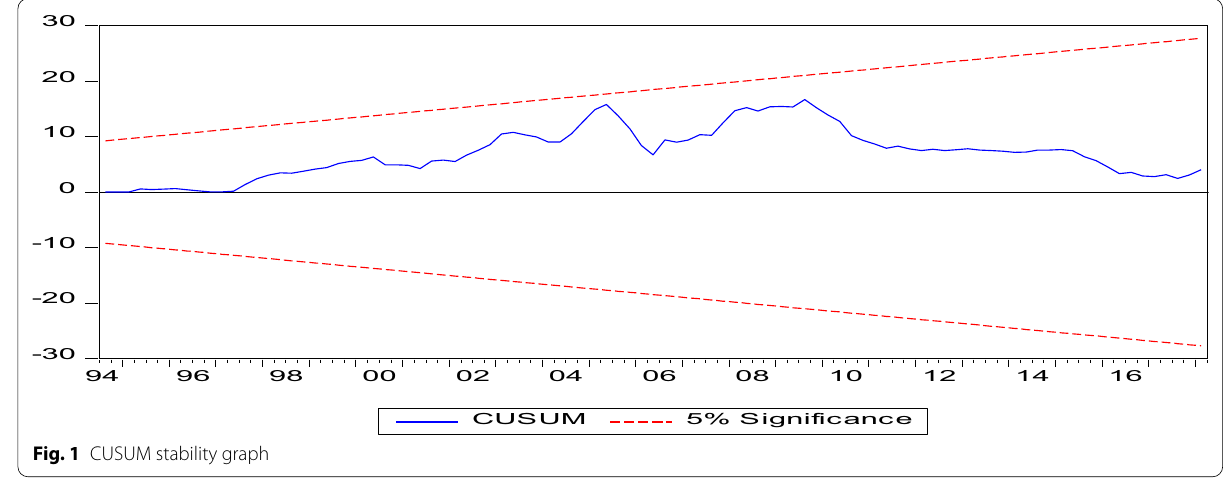
Fig. 1 CUSUM stability graph